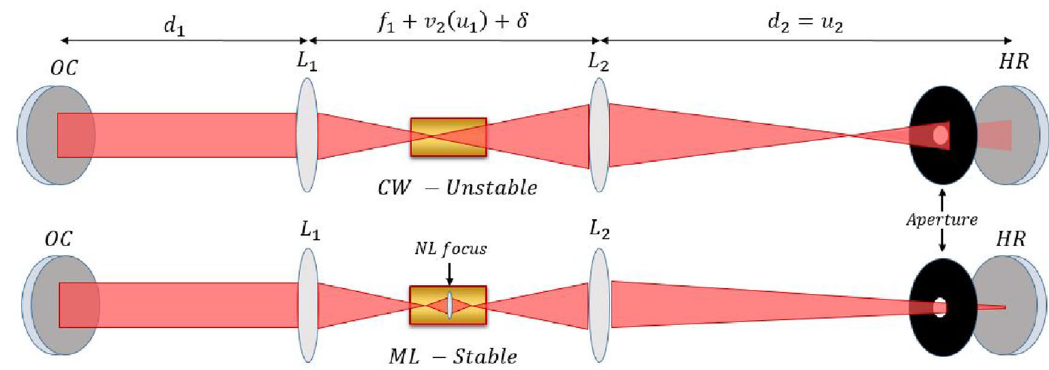
Figure 1. The soliton model of KLM: The Kerr effect in the gain medium acts to focus the beam (red) inside the cavity, mitigating diffraction losses for pulses with high peak power. (top) Linear beam propagation inside the cavity (bottom) Beam propagation with the Kerr lens for pulsed operation. d 12 are the distances in the free propagation arms of the cavity, between the end mirrors (denoted by OC and HR ) and the focusing elements (denoted L 1,2 ) with focal lengths f 1,2 , respectively. The total distance between the focusing elements deviates from the imaging condition by δ , which quantifies the cavity stability (or deviation from it). The aperture, which illustrates the role of the diffraction losses in the cavity, can be an actual element or an effective aperture induced by the overlap between the cavity mode and the pump beam in the gain medium.